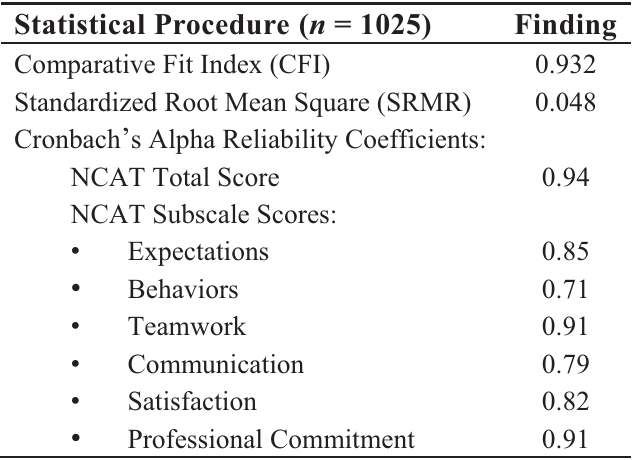
Table 1. The Nursing Culture Assessment Tool’s (NCAT) Comparative Fit Index, Standardized Root Mean Square, and Reliability